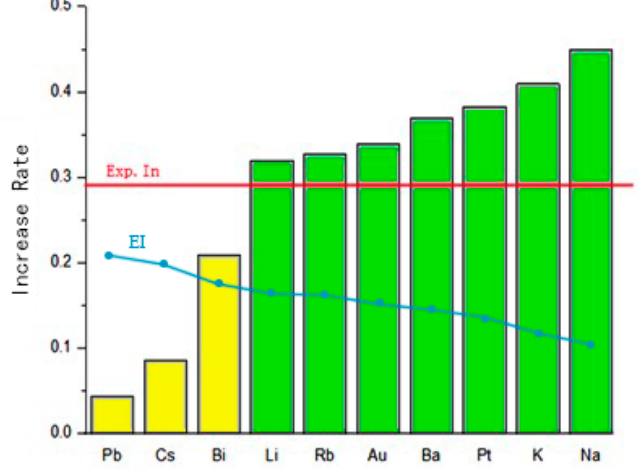
Figure 5. Prediction of the 1st Gaussian process regression (GPR) model selected by the expected improvement (EI) ranking.